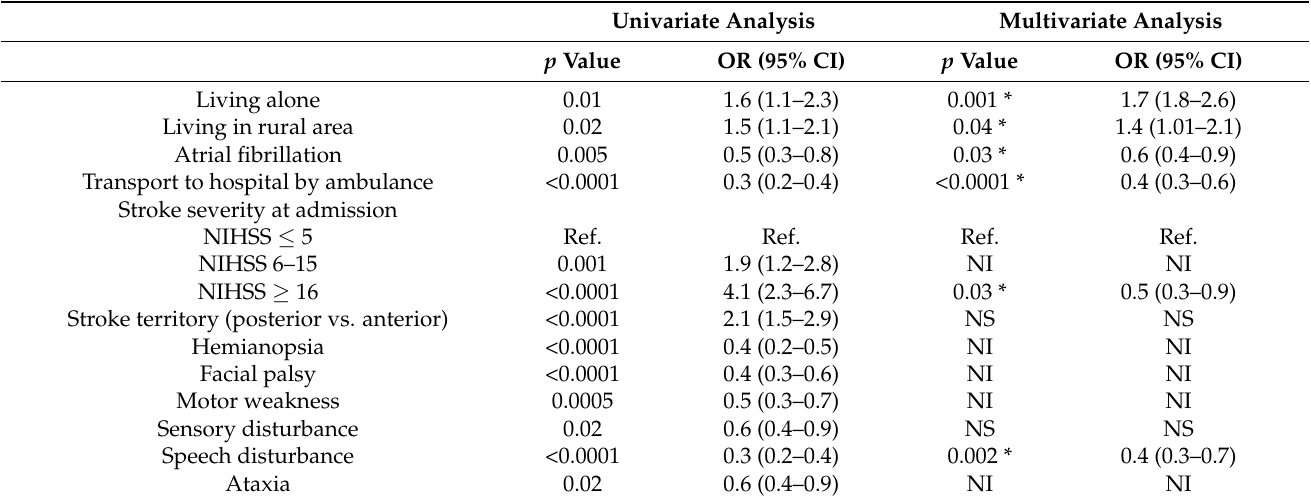
Table 4. Factors associated with hospital arrival after 24 h from stroke